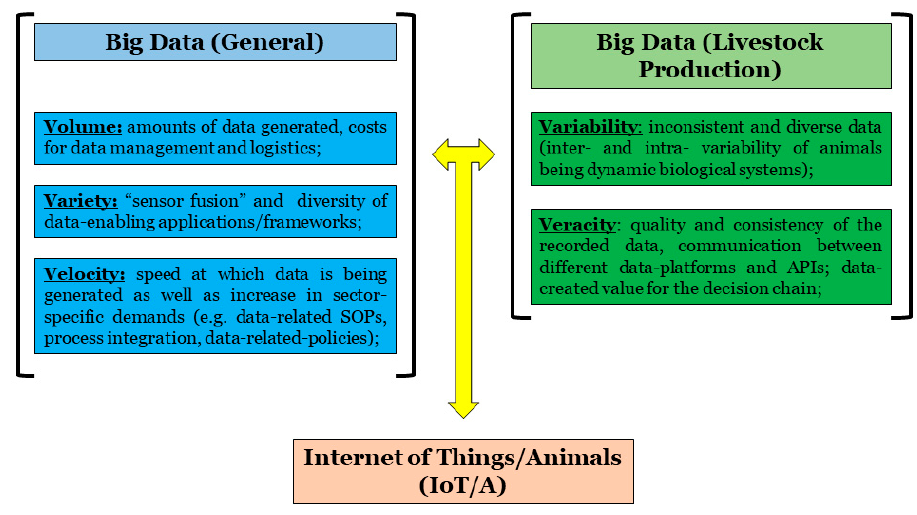
Figure 3. Big data in livestock production.